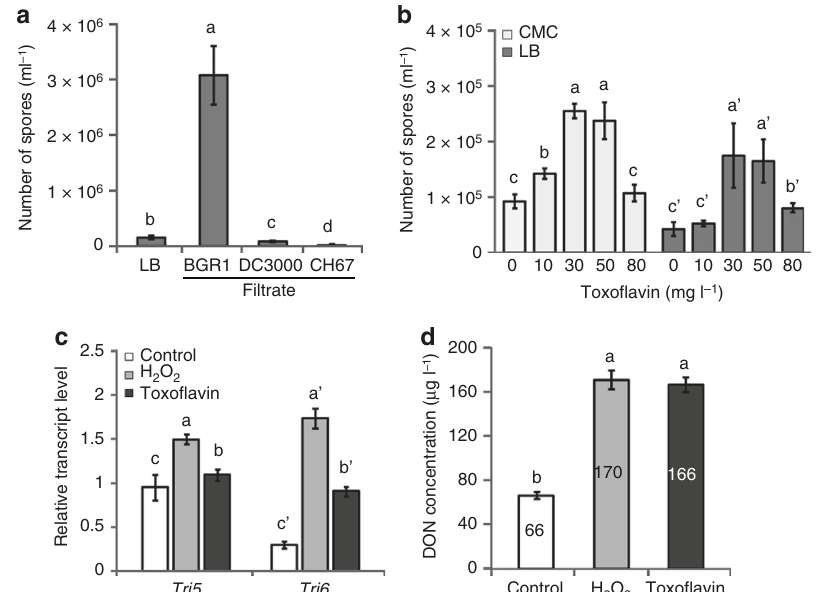
Fig. 4 Effects of toxo fl avin on the generation of spores and DON production. a Effect of bacterial fi ltrates on Fg spore production. WT strain GZ03639 was incubated with bacterial culture fi ltrates for 24 h. BGR1: Bg, DC3000: Pseudomonas syringae , CH67: Burkholderia pyrrocinia . b Effect of toxo fl avin on Fg spore production. GZ03639 was incubated for 24 h in CMC or LB medium supplemented with toxo fl avin at the concentrations indicated. c Effect of toxo fl avin on transcription of the trichothecene biosynthesis genes, Tri5 and Tri6 , in GZ03639 grown in GYEP medium (control) and in the presence of toxo fl avin